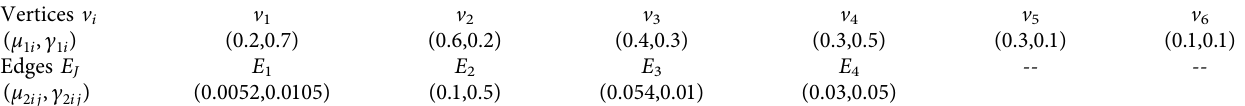
Table 5: Degree of membership and nonmembership values for vertices and edges of Figure 5.